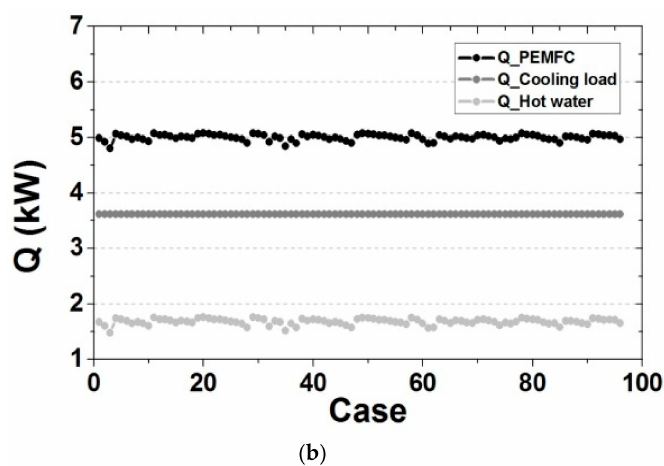
Figure 4. Comparison of PEMFC stack heating value, cooling, and hot water (heating) load by absorption cooling performance. ( a ) Absorption cooling capacity: 2.0 kW; ( b ) Absorption cooling capacity: 2.5 kW.